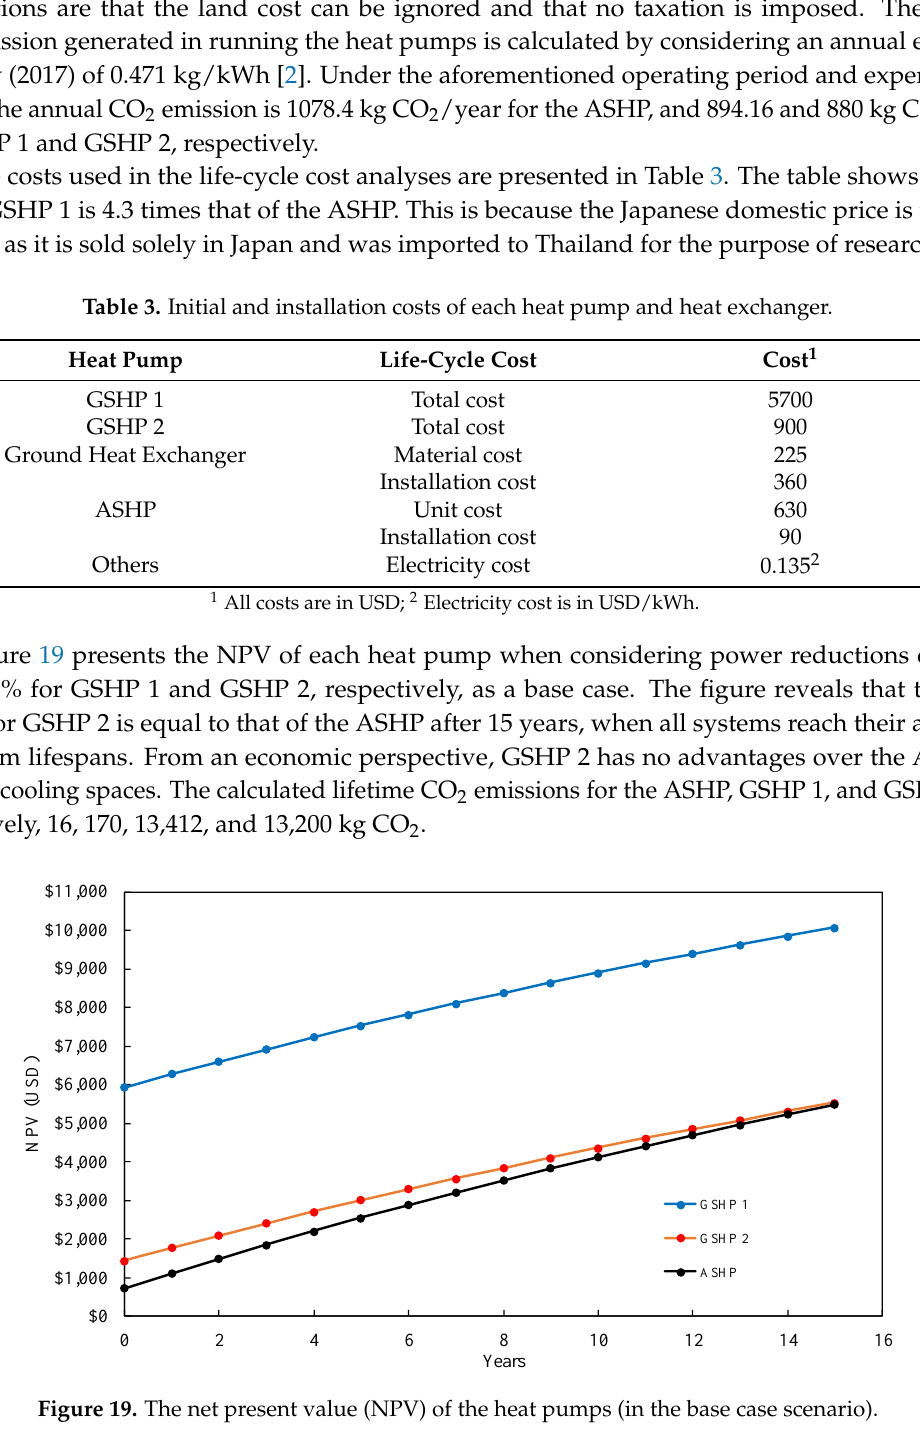
Figure 20. NPV of the heat pumps assuming the GSHP uses 40% less power than the ASHP.